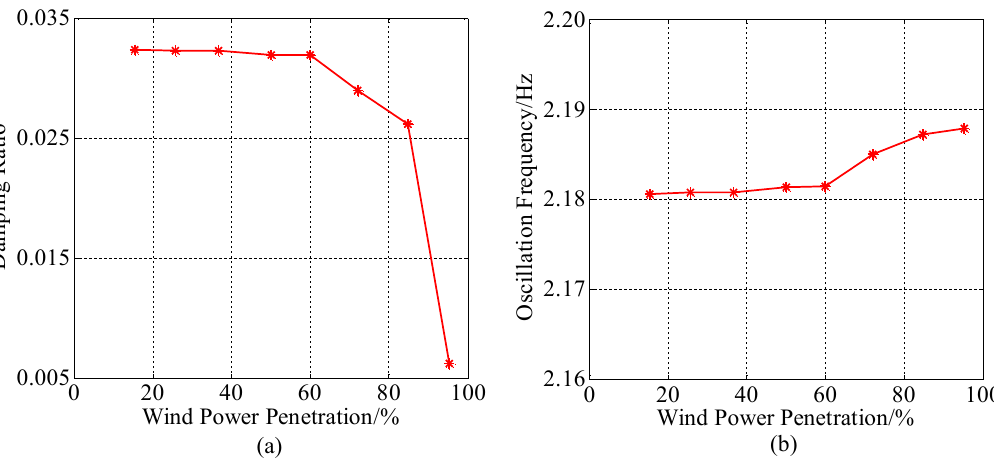
Figure 5. Damping ratio and frequency of the strong-interaction mode vs. wind power penetration. ( a ) the damping ratios of the strong-interaction modes; ( b ) the frequencies of the strong-interaction modes.